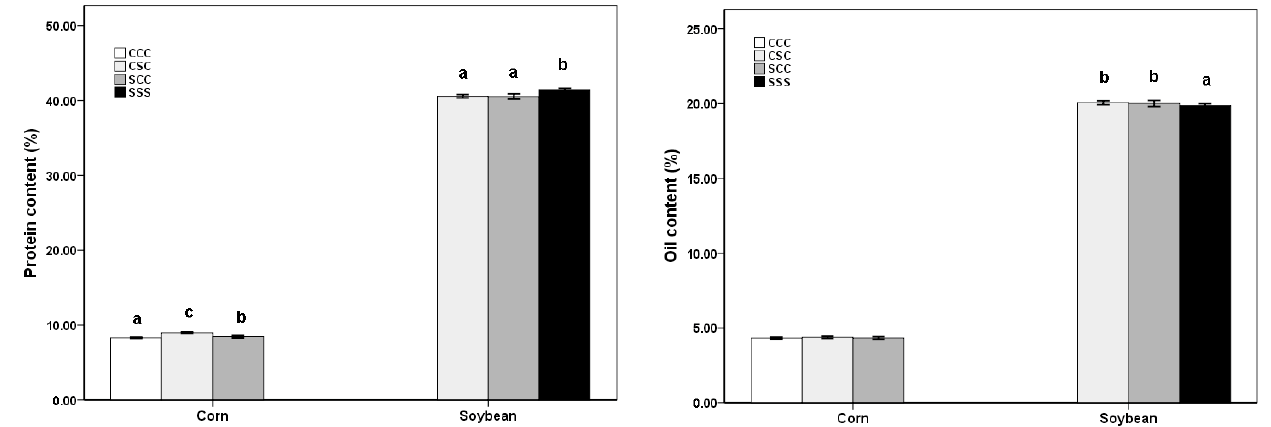
Figure 3. Protein and oil content of corn and soybean under different crop rotations. Different lowercase letters indicate significant differences at p < 0.05 using Fisher’s least significant difference.